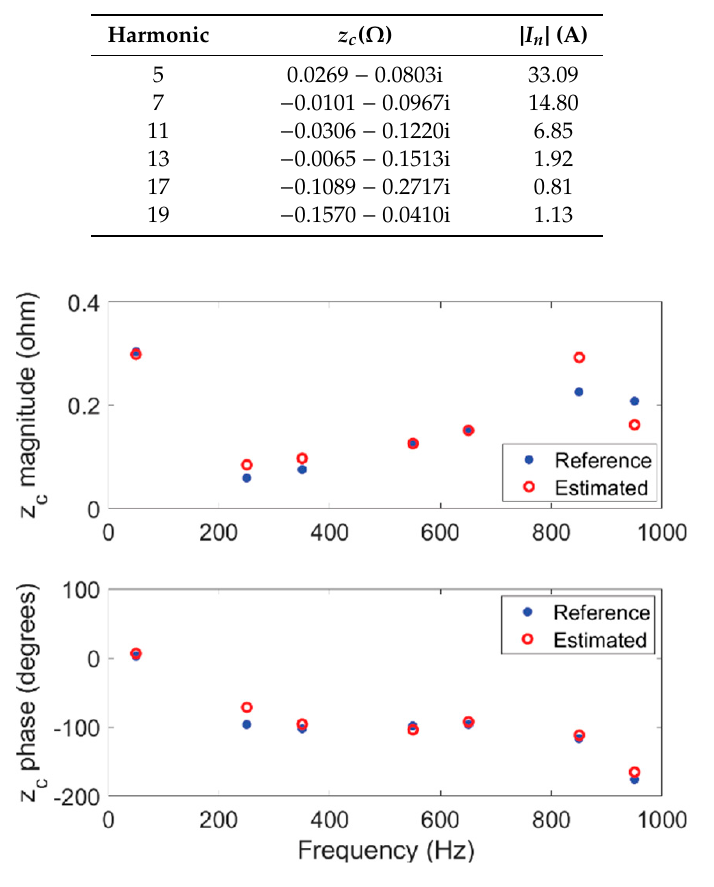
Figure 7. The reference and the estimated impedance of the sub-grid seen from PCC-LV.